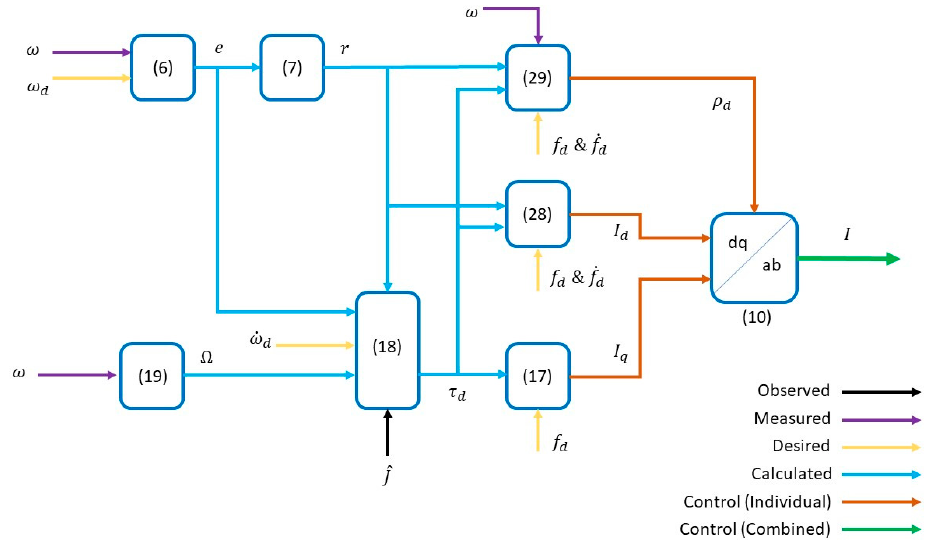
Figure 3. Nonlinear control diagram.